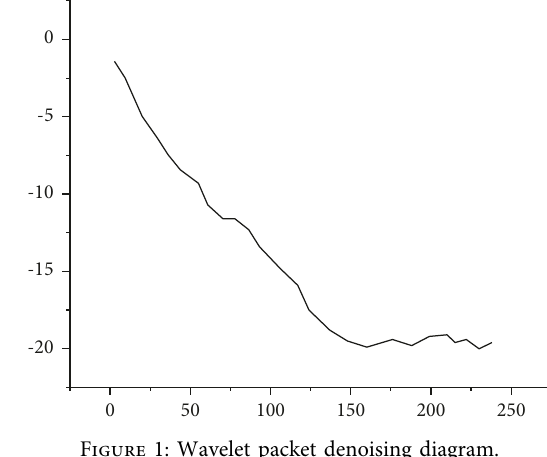
Figure 1: Wavelet packet denoising